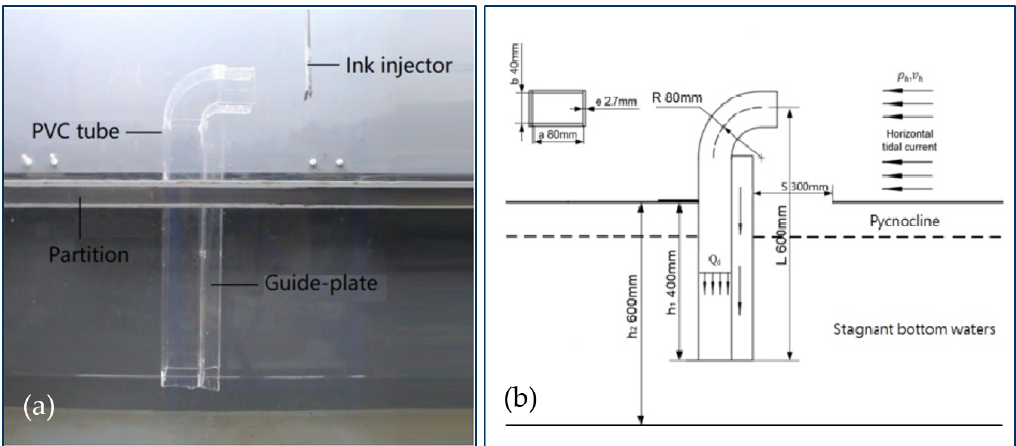
Figure 6. The laboratory models of the improved current-induced pump. (a) Experimental picture, (b) Diagram of the model size [54].